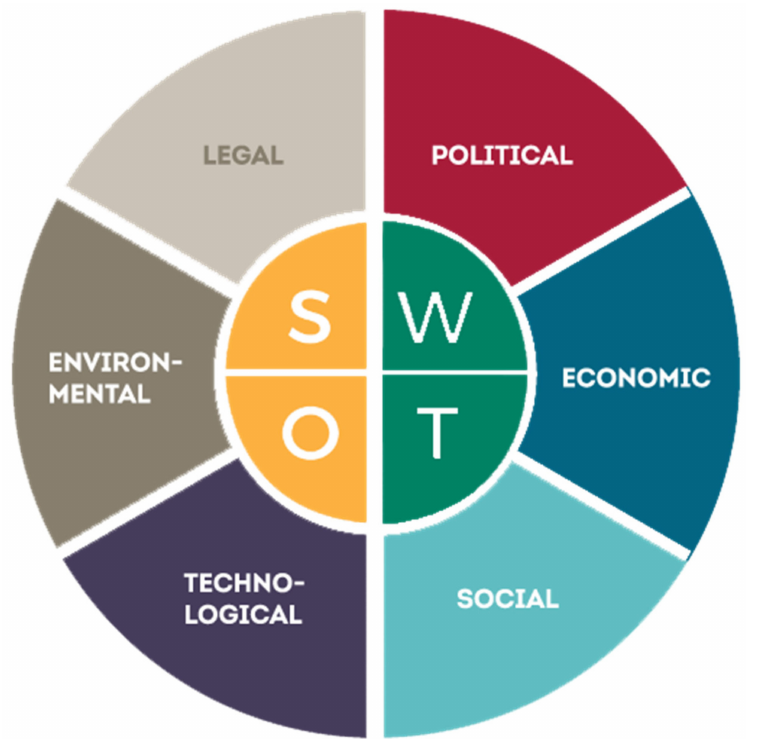
Figure 1. Combining PESTLE framework with SWOT